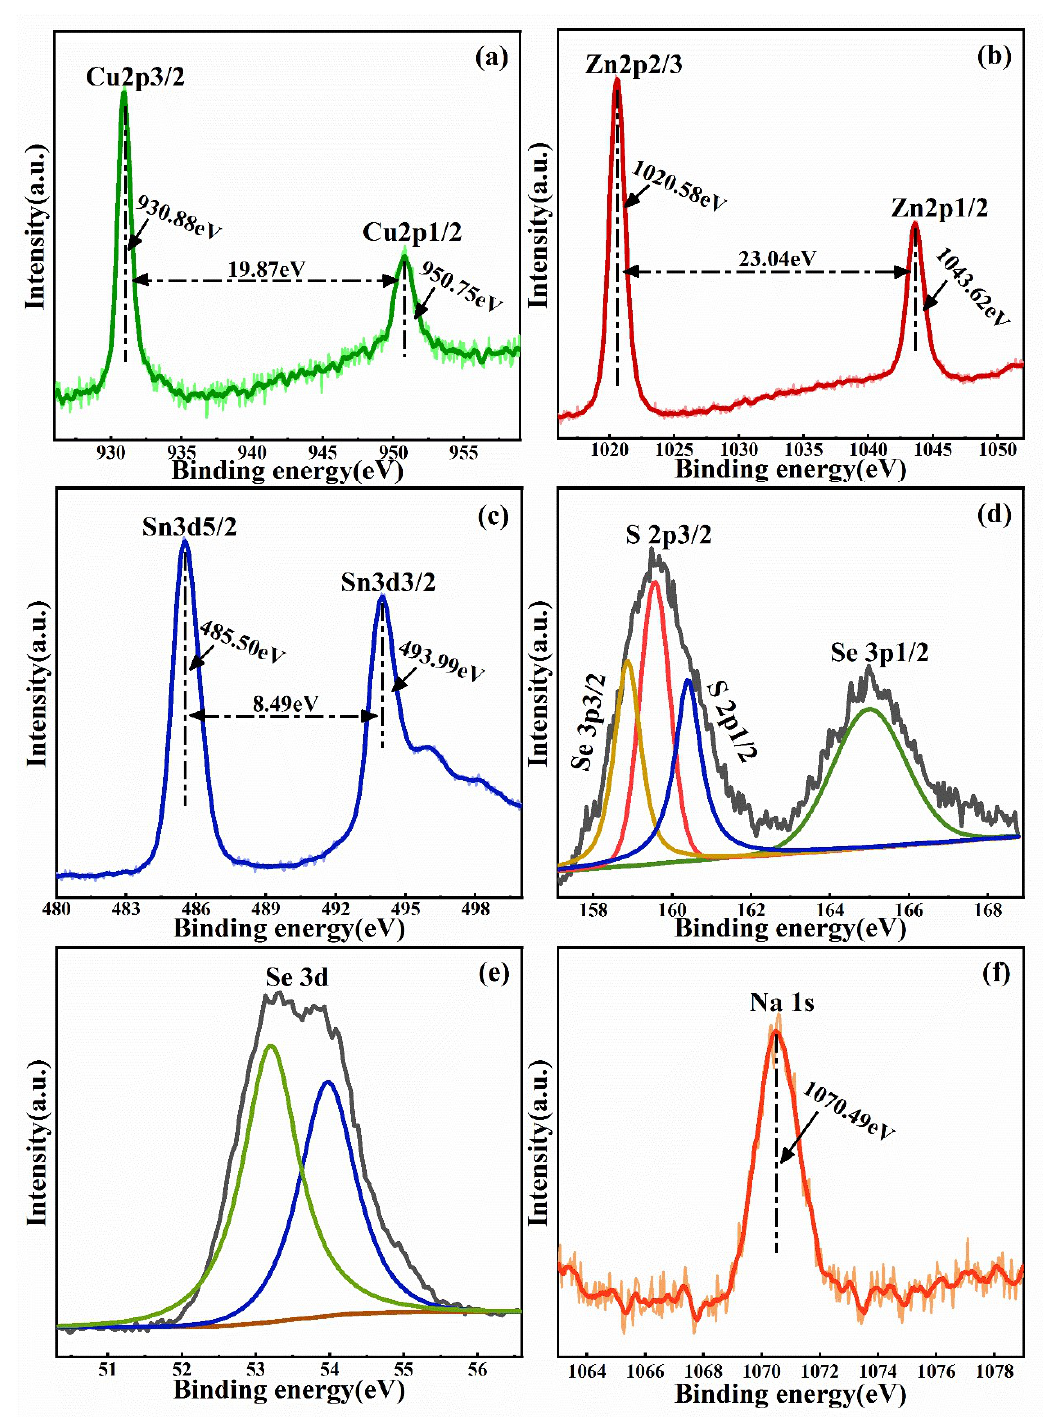
Figure 3. XPS spectra of Na-doped Cu 2 ZnSn(S,Se) 4 film selenized at 540 °C: ( a ) Cu, ( b ) Zn, ( c ) Sn, ( d ) Se, ( e ) S and ( f ) Na.